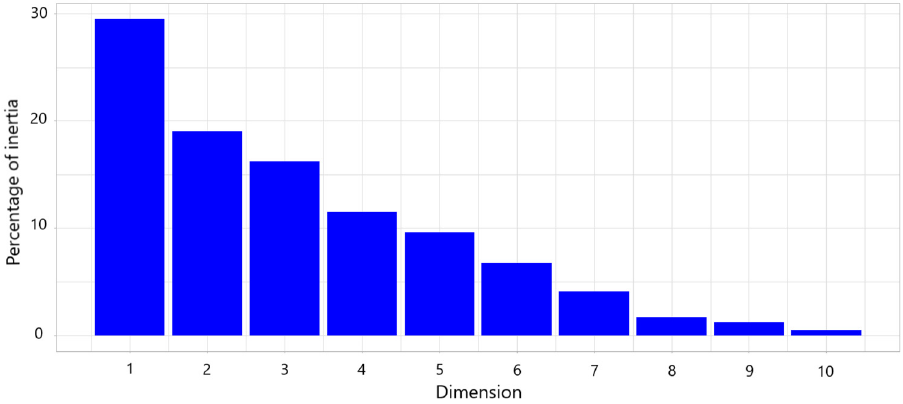
Figure 9. The total inertia decomposition of landslide PCA.